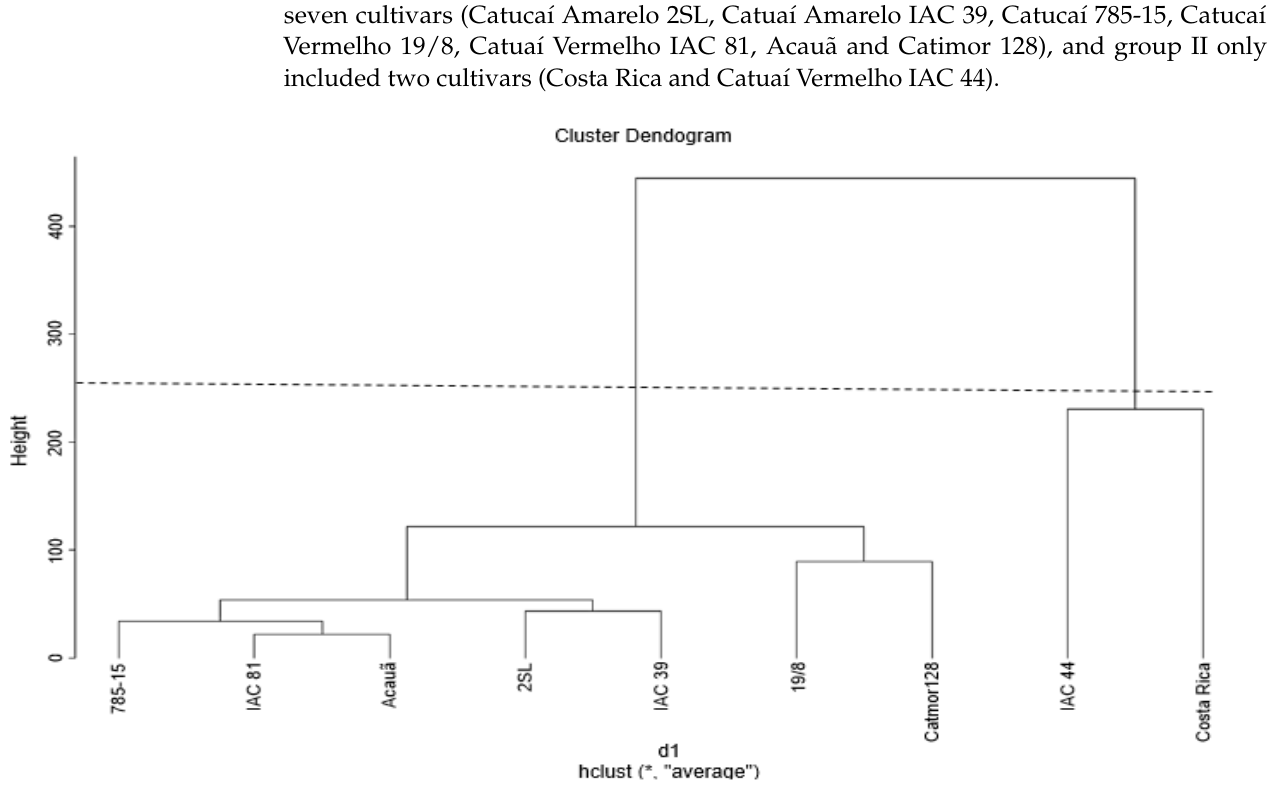
Figure 1. Dissimilarity dendrogram for nine Coffea arabica cultivars, grouped by UPGMA, using Mahalanobis’ generalized distance. Co-phenetic correlation: 0.8332. Slight differences were observed between the clustering methods, as the cultivars were also divided into two groups using the Tocher method. One group contained only one cultivar (Catua í Vermelho IAC 44), while the other seven genotypes formed a second group (Table 4). For both UPGMA and Tocher methods, the cultivar Catua í Vermelho IAC 44 was considered divergent because of its high dissimilarity degree. Table 4. Clusters of the variables of coffee bean, husk, fruits and leaves, and nutrient concentration and accumulation in nine Coffea arabica L. cultivars, grown in the Gorongosa Mountain, Gorongosa National Park, Sofala, Mozambique, grouped by the Tocher method and Mahalanobis generalized distance (D2), with an average distance between the clusters of 362.9995.